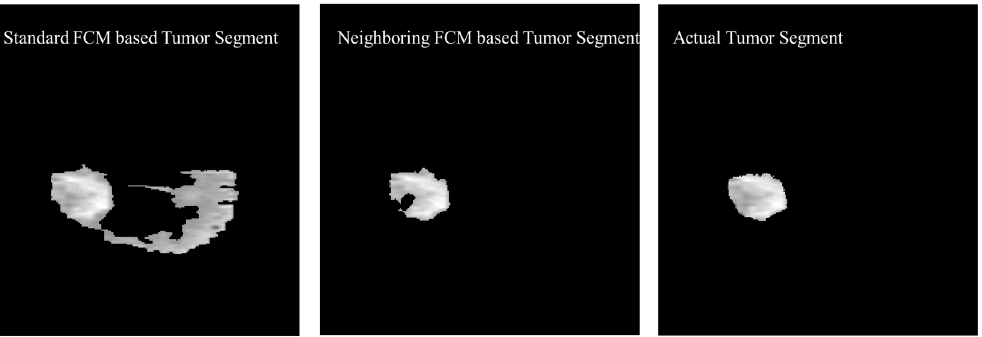
Figure 15. Visual Comparison of the Standard FCM based tumor segment with the Neighboring FCM based tumor segment and the actual tumor segment. Table 11. Comparison of the proposed brain Tumor Segmentation method with latest literature